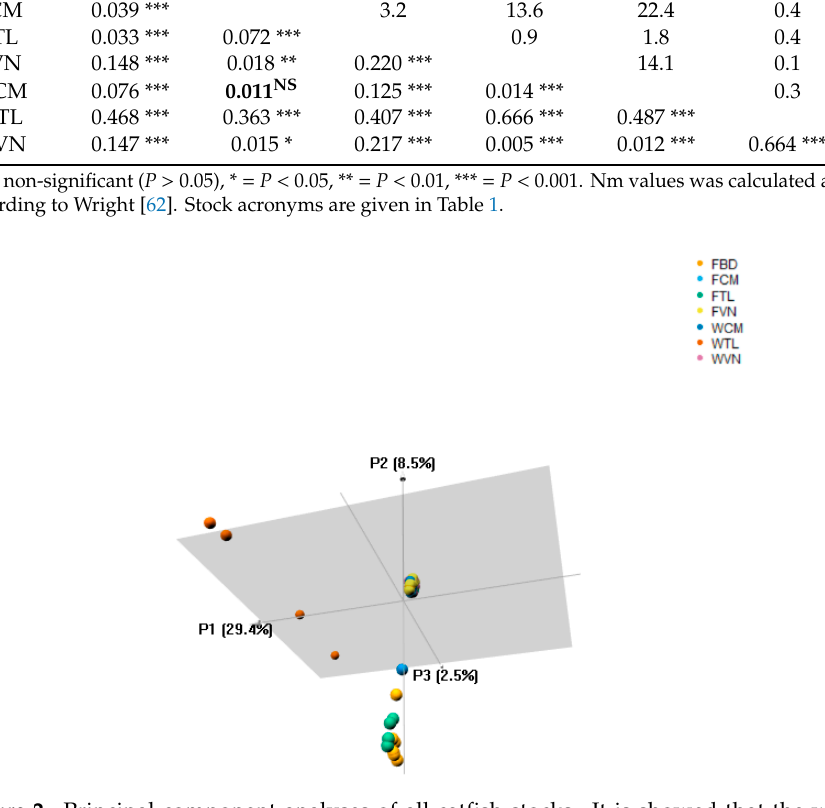
Figure 2. Principal component analyses of all catfish stocks. It is showed that the wild catfish in Thailand had greater genetic distances to the other samples. Abbreviations are given in Table 1. Table 3. Pairwise F ST genetic distance (below diagonal) and gene flow Nm (above diagonal) between populations.